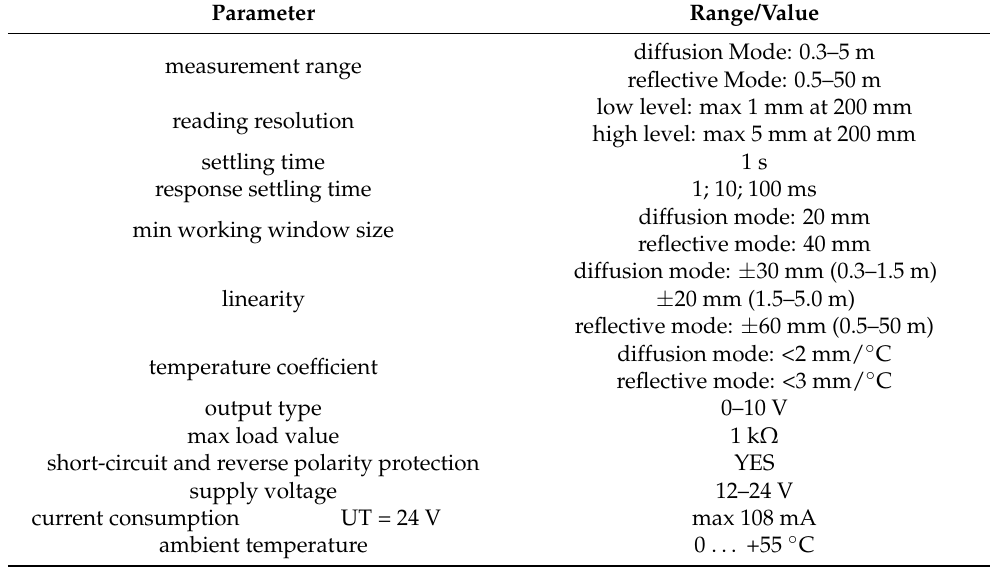
Table 1. Laser rangefinder parameters.